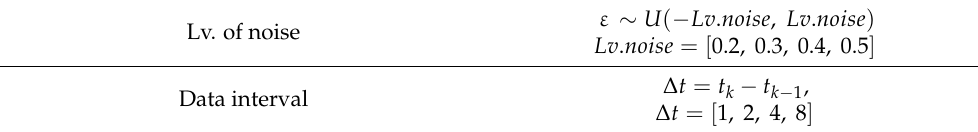
Table 1. Sensor data design parameters.